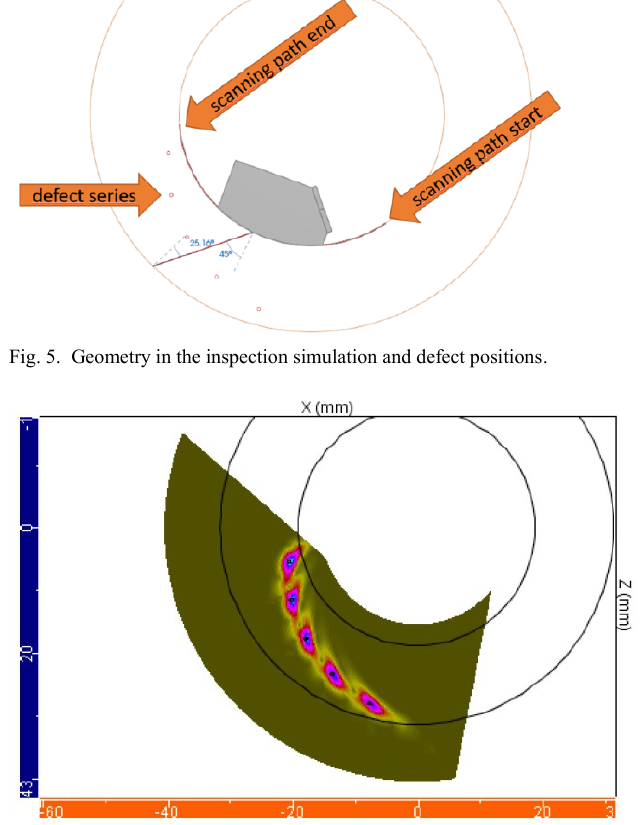
Fig. 6. B-scan of a SDH defect series.